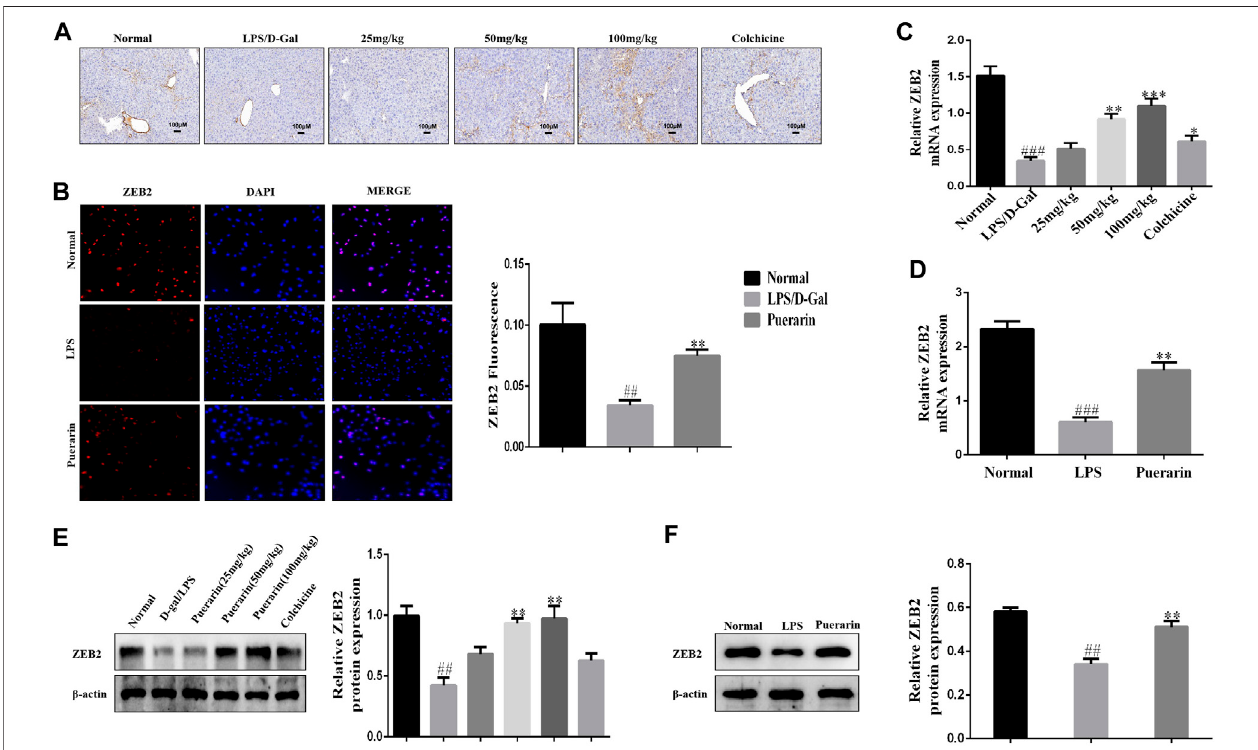
FIGURE3| Puerarinelevated theexpressionlevelofZEB2withALIandLPS-inducedL-02cellsinmice. (A) :Representativeimmunohistochemicalstainedimages of ZEB2. (B) : Representative immuno fl uorescence stained images of ZEB2. (C) and (D) : The mRNA expression levels of ZEB2 were measured using qRT-PCR in liver tissues with ALI and LPS-induced L-02 cells. (E) and (F) : The protein expression levels of ZEB2 were measured using WB analyses in liver tissues with ALI and LPS- inducedL-02cells.Theassayswereperformedatleastthreetimes,withsimilarresults.Dataareshownasthemeans ± SD( n (cid:2) 3)ofonerepresentativeexperiment; ###p < 0.001 and ##p < 0.01 versus normal groups; ***p < 0.001 and **p < 0.01 and *p < 0.05 versus the LPS